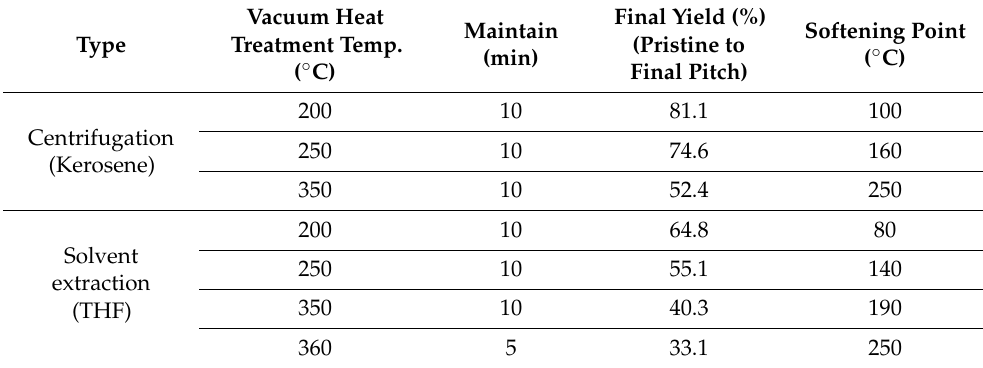
Table 2. The analysis results of the yield and softening point according to solvent extraction and